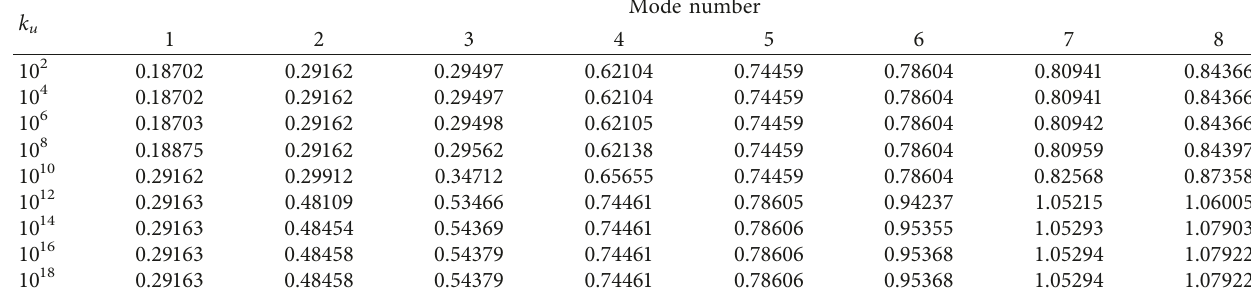
Table 4: Comparison of the frequency parameters Ω of an orthotropic plate elastically restrained in the z direction. k u